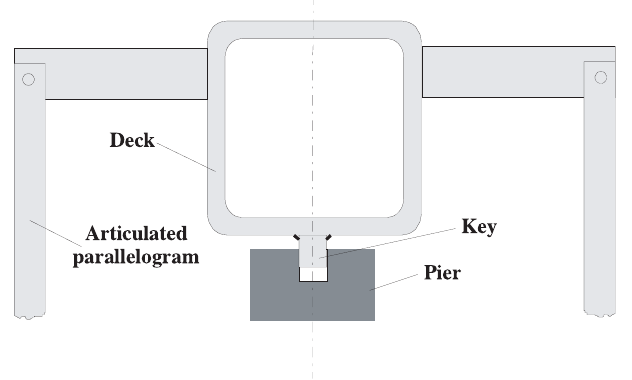
Fig. 3. Connection of the piers to the deck.